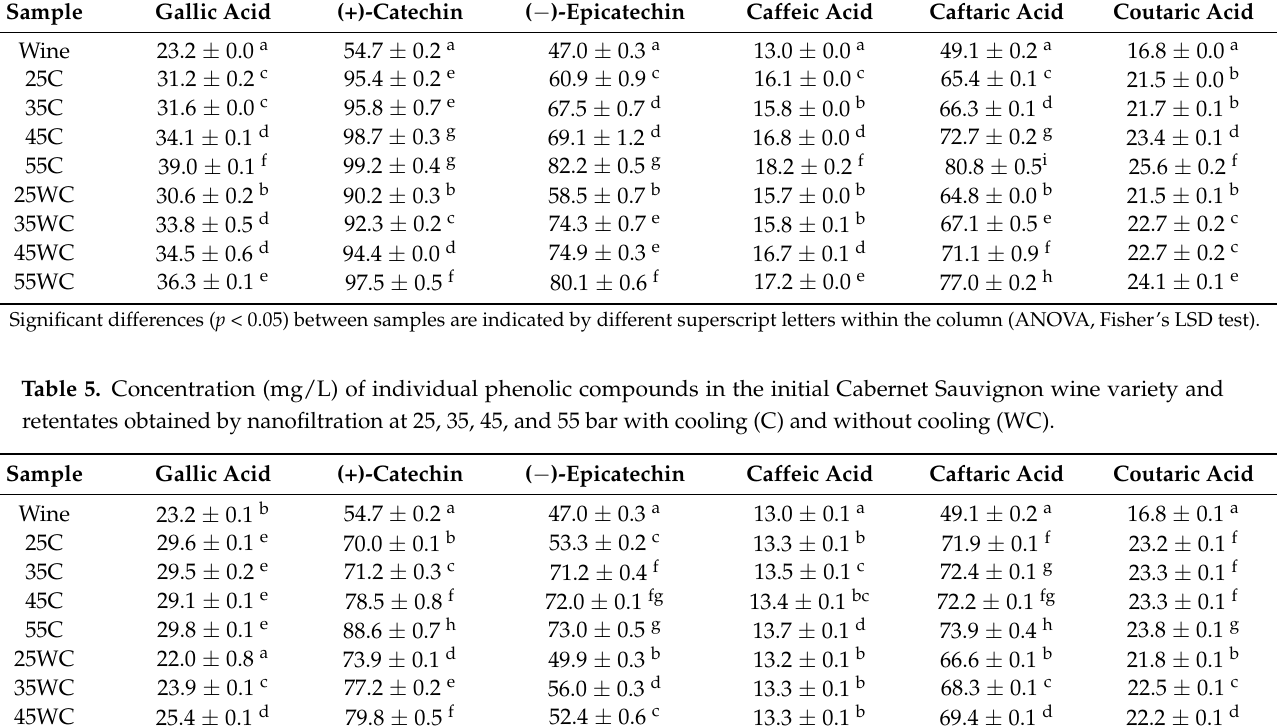
Table 4. Concentration (mg/L) of individual phenolic compounds in the initial Cabernet Sauvignon wine variety and retentates obtained by reverse osmosis at 25, 35, 45, and 55 bar with cooling (C) and without cooling (WC). Sample